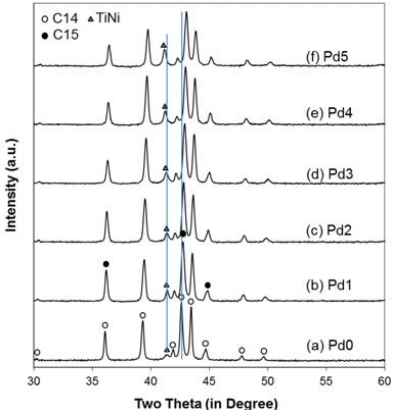
Figure 1. X ‐ ray diffraction (XRD) patterns using Cu ‐ K α as the radiation source for alloys ( a ) Pd0, ( b ) Pd1, ( c ) Pd2, ( d ) Pd3, ( e ) Pd4, and ( f ) Pd5. In addition to the two Laves phases, another cubic phase is